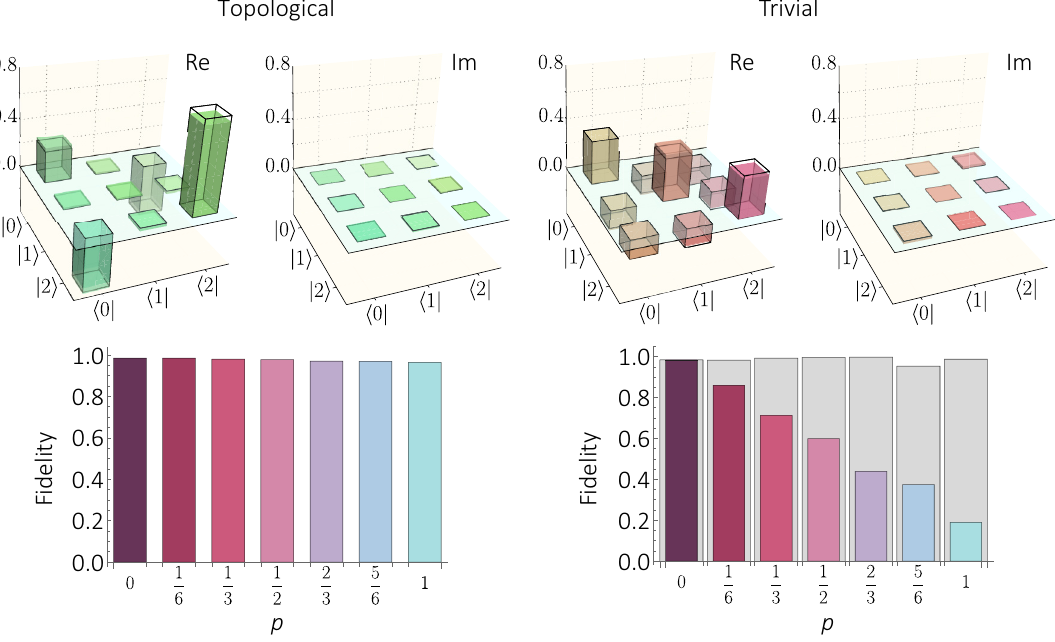
FIG. 8. An additional experimental result on the observation of contextuality in a parafermionic encoded system. The graph on the left-hand side shows the result for parafermionic qutrits and the graph on the right-hand side that nontopological qutrits. Top: the real and imaginary parts of the sample density matrices for the data points corresponding to p = 2 / 3 hopping probability from quantum state tomography. The edge (filling) gives the theoretical (experimental) values. Bottom: the calculated state fidelity between the experimental result and the theoretical prediction for each data point. In the graph on the right-hand side, the gray and colored bars represent the fidelity with respect to the theoretical state when the effect of flip errors is taken and not taken into account in advance,